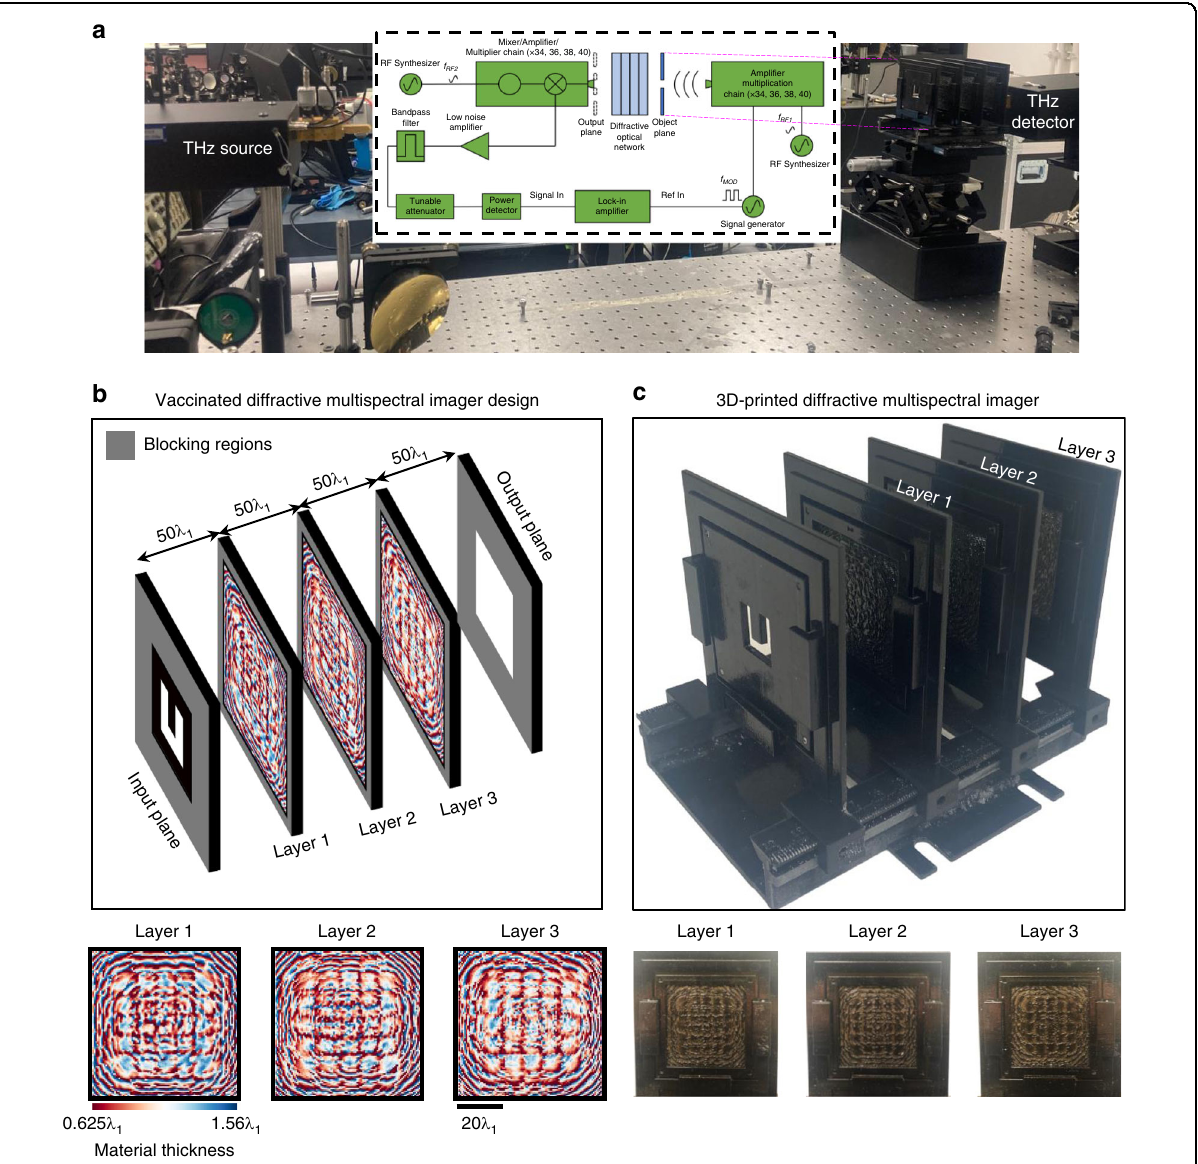
Fig. 6 Experimental setup of the multispectral terahertz imager ð N B ¼ 4 Þ . a Schematic of the experimental setup using terahertz illumination and signal detection. b Optical design layout of the fabricated diffractive multispectral imager and the material thickness pro fi les of the 3 diffractive surfaces. c Fabricated diffractive network and the input object, the letter ‘ U